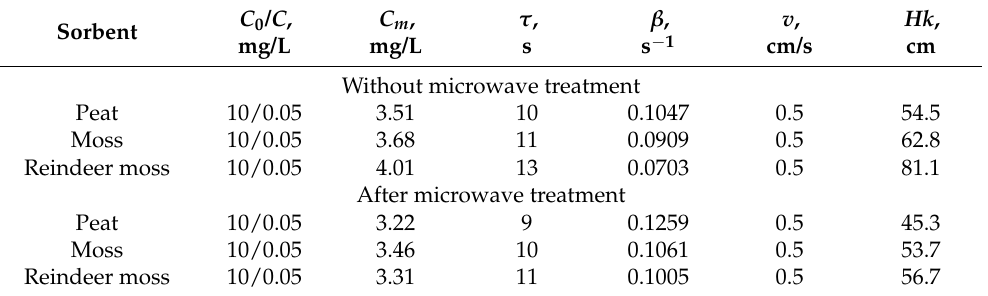
Table 5. The technological parameters of the filter